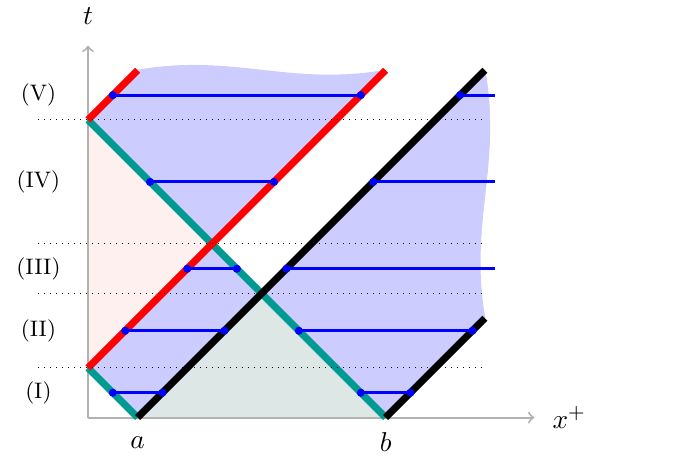
bordered in black, the reflected modes ˆ A ( l ) R